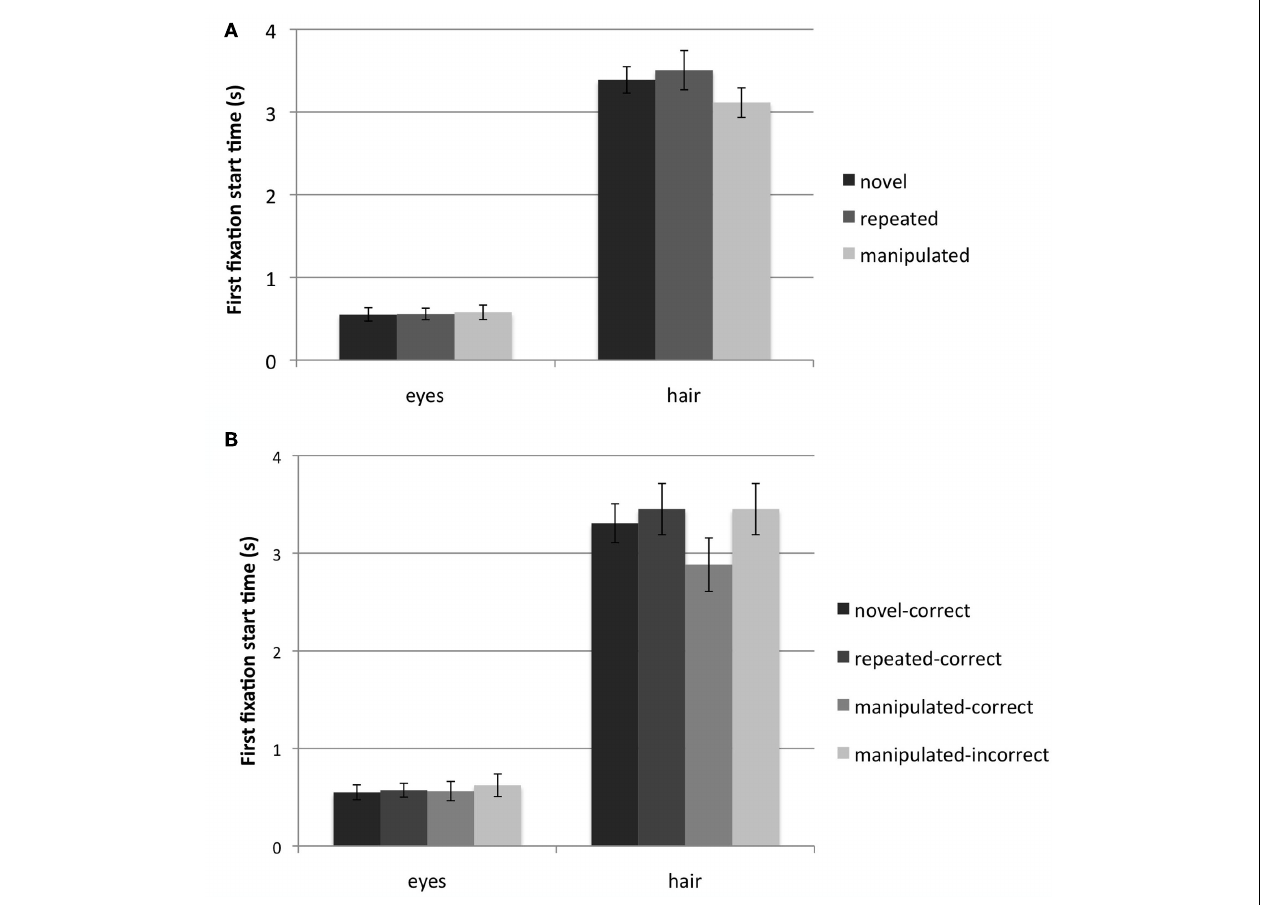
FIGURE 2 |Time (seconds) of the first fixation made to the eye and hair regions for (A) face type: novel, repeated, and manipulated faces; (B) response type: novel-correct, repeated-correct, manipulated-correct, manipulated-incorrect. Error bars represent SEM.